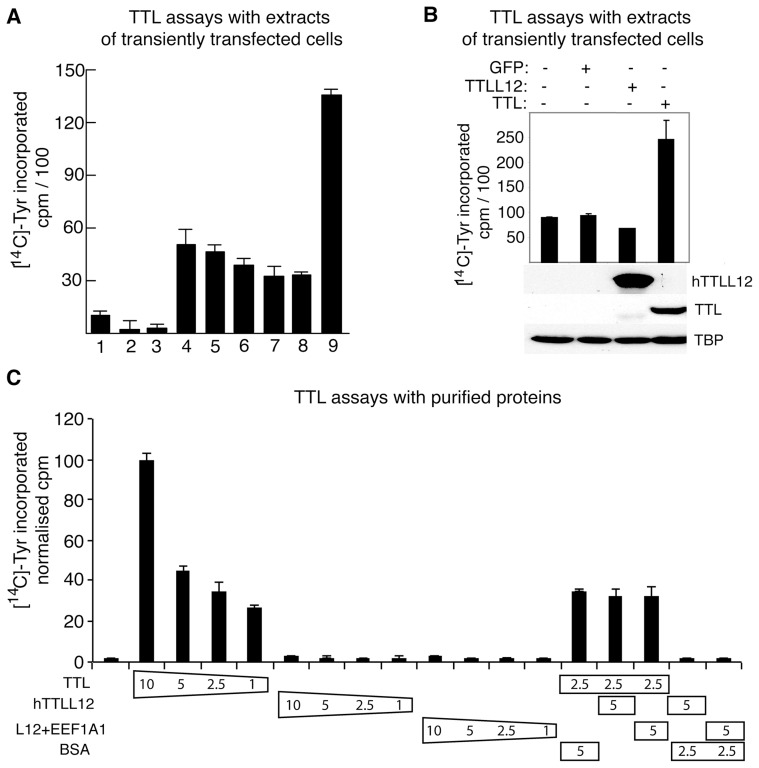
hTTLL12 lacks tubulin tyrosine ligase activity, as shown with tubulin tyrosine ligase (TTL) assays using cell extracts (A, B) or purified proteins (C).(A) TTL assays on extracts of transfected HEp-2 cells. Control reactions lacked cell extract (1), ATP (2) or purified tubulin (3). Test reactions contained extracts from cells transfected with: no DNA (4, mock), pc-AS 153 (5, antisense hTTLL12), pcDNA3-hTTLL12 (6), pSG5-puro-hFlag TTLL12 (7, Flag-hTTLL12), pc-AS TTL (8, antisense hTTL), and pcDNA3-TTL (9). (B) Expression of TTLL12 and TTL in transfected cell extracts. WBs were used to detect hTTLL12, TTL and TBP (loading control) in the extracts used for the activity tests. (C). TTL activity of purified proteins. The in-vitro reactions contained the indicated quantities (µg) of TTL, hTTLL12 and hTTLL12 complexed to EEF1A1 that had been purified from mammalian cells infected with corresponding recombinant Ankara strain (MVA) vaccinia viruses. The counts were normalised to 100 for 10 µg TTL. Error bars indicate standard deviations.